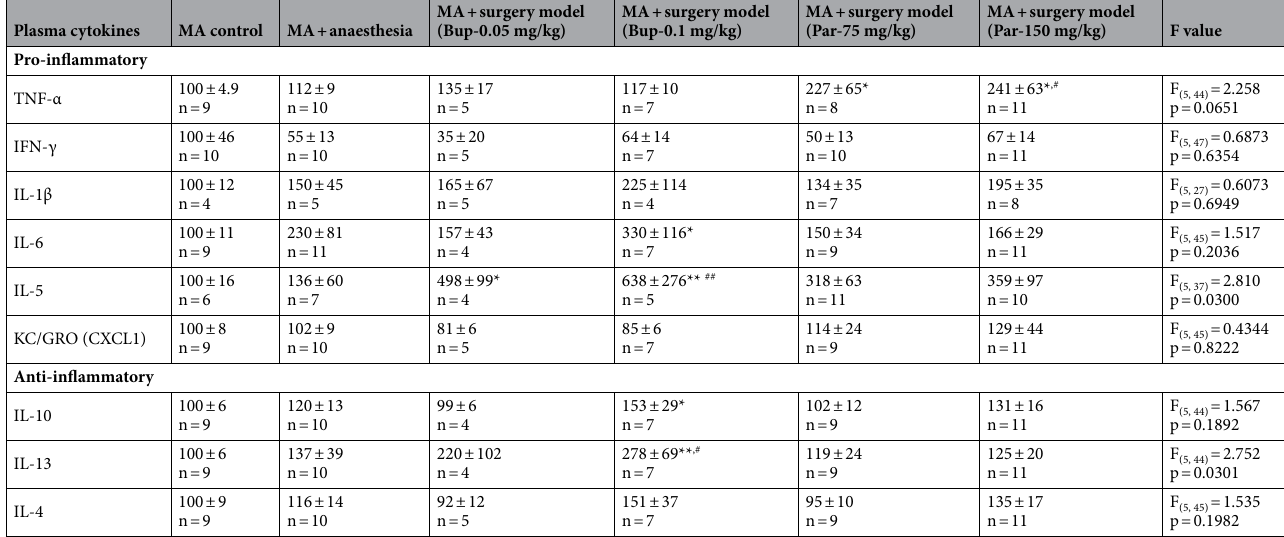
Table 1. Analysis of circulating cytokine levels in plasma. Data are expressed as a percentage of the MA Control group (mean ± SEM), n = 5–11 per group. One-way ANOVA followed by Fisher’s LSD analysis